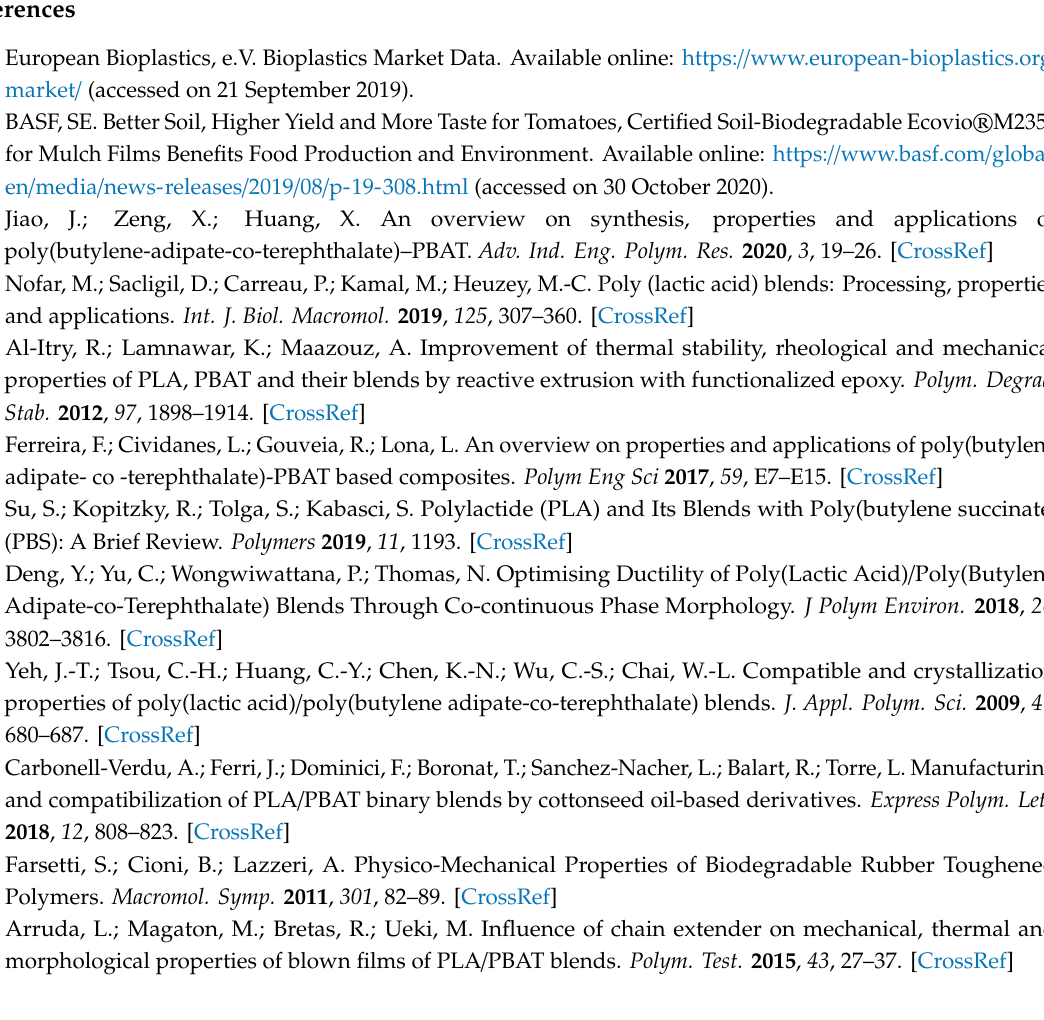
Figure S1: DSC of pure PLA analyzed by the software Netzsch Proteus Thermal analysis, Figure S2: SEM of further flat films made of PBAT / PLA blends: (a) (80 / 20) in CD, (b) (80 / 20) in MD, (c) (70 / 30) in CD, (d) (70 / 30) in MD, (e) (20 / 80) in CD, (f) (20 / 80) in MD, (g) (10 / 90) in CD, (h) (10 / 90) in